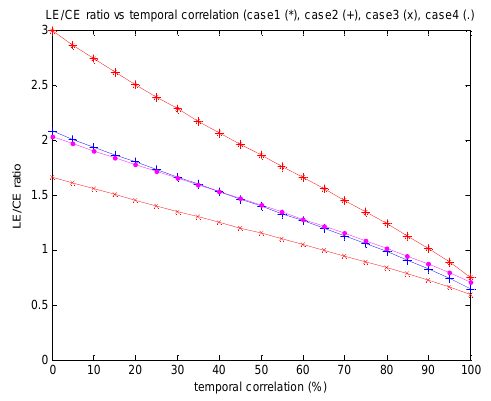
Figure 12. Predicted LE/CE for the baseline, two extreme cases of imaging geometry, the baseline plus asymmetry